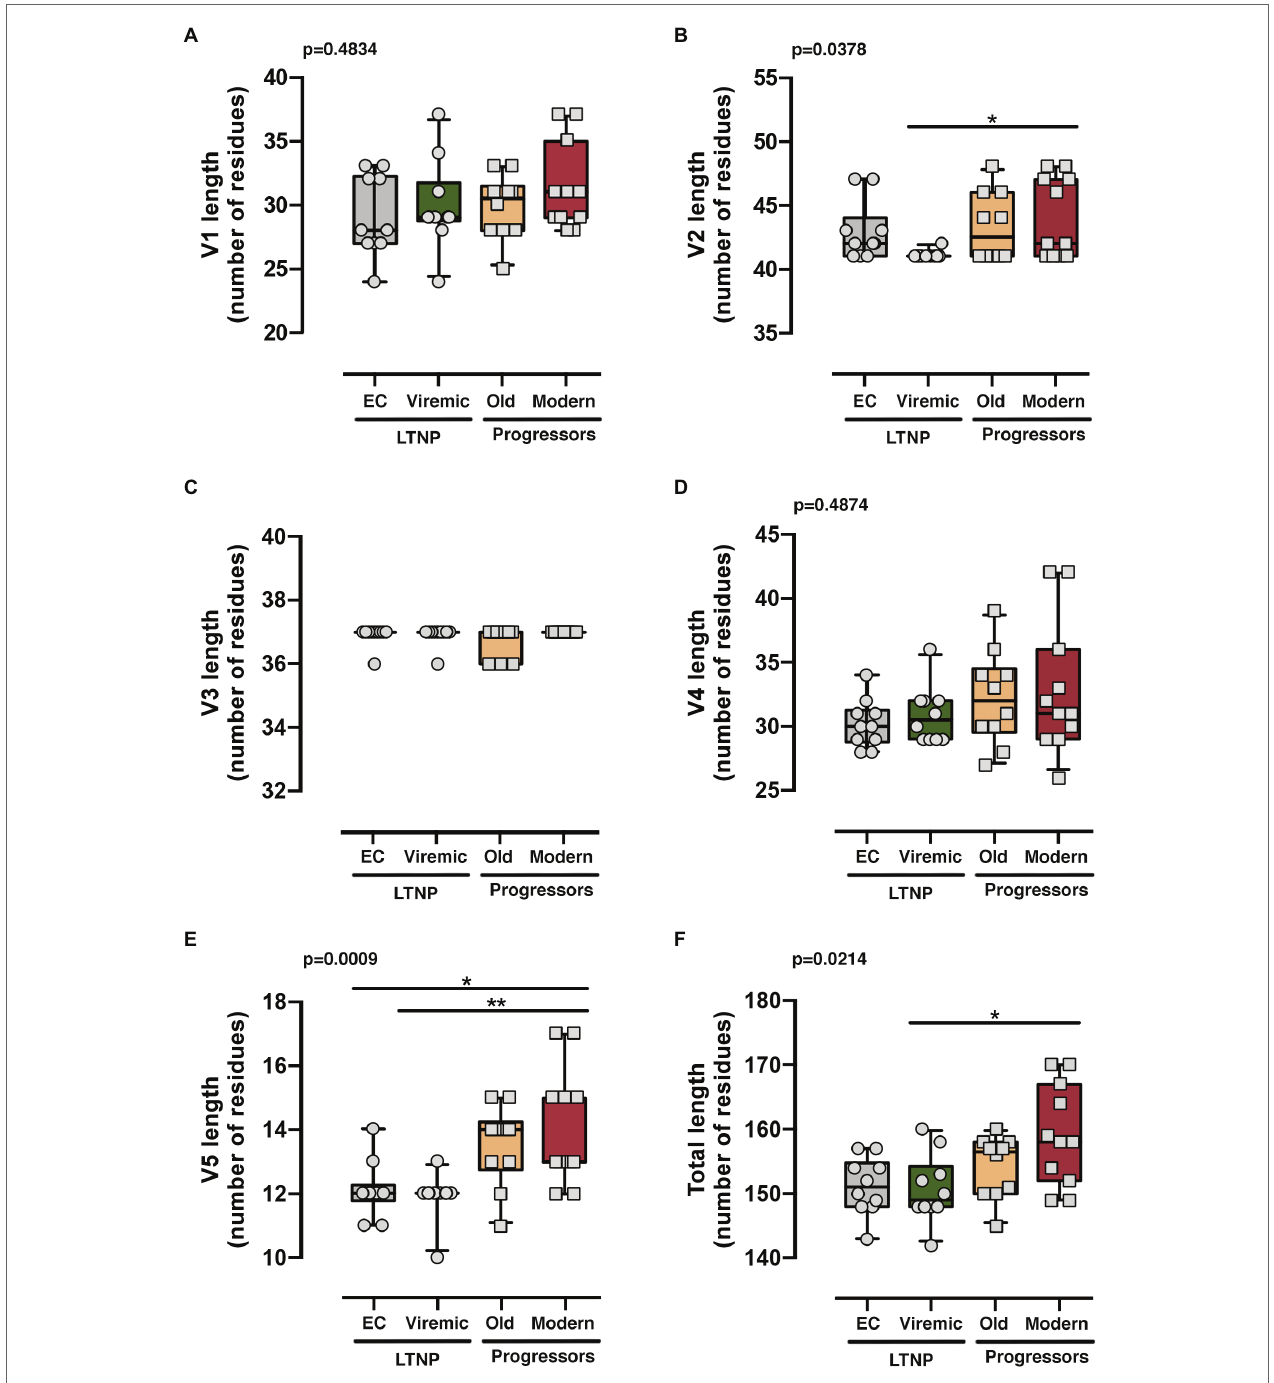
FIGURE 7 | Analysis of the length of the loops of the Envs from the different groups. Analysis of the length of each variable loops V1 (A) , V2 (B) , V3 (C) , V4 (D) , V5 (E) , and all variable loops together (F) . The results were grouped [LTNP-ECs: gray bar , vLTNPs: green bar , Old patients: orange bar , and recent patients (Moderns): red bar ] and compared using a nonparametric Kruskal–Wallis, Dunn’s Multiple Comparisons Test; p value for comparison between all groups is shown, top left . When indicated, comparative p values between groups are * p <0.01 and ** p <0.05. Lines are mean, boxes 25th and 75th percentiles, and bars minimal and maximal values, considering the characteristics (i.e., loop length) of all Envs analyzed from the different